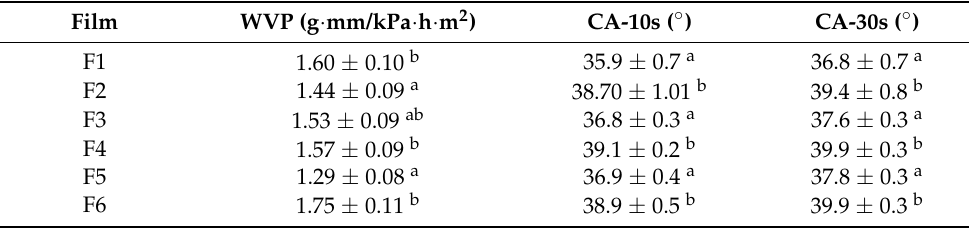
Table 4. Water vapor permeability (WVP) and contact angle (CA) at 10 and 30 s of the